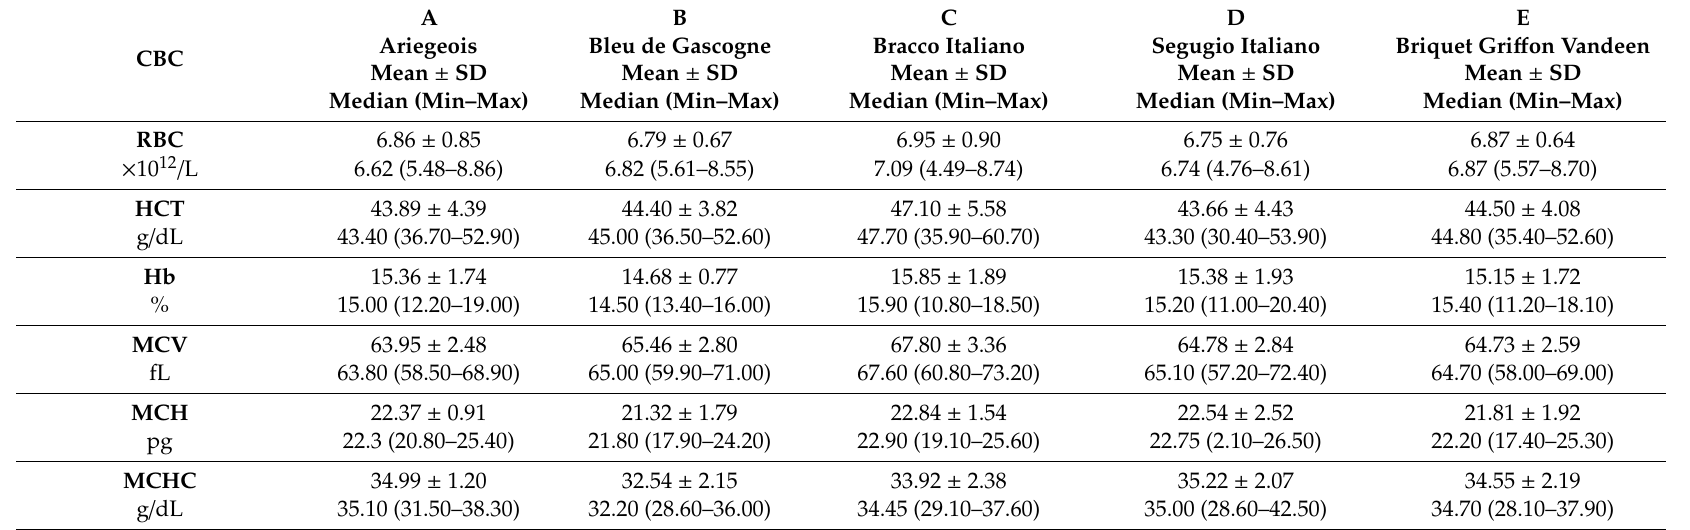
Table 3. Mean, standard deviation, median, maximum, and minimum values for each hunting dog breed (A: Ariegois; B: Bleu de gascogne; C: Bracco italiano; D: Segugio italiano; E: Briquet Gri ff on